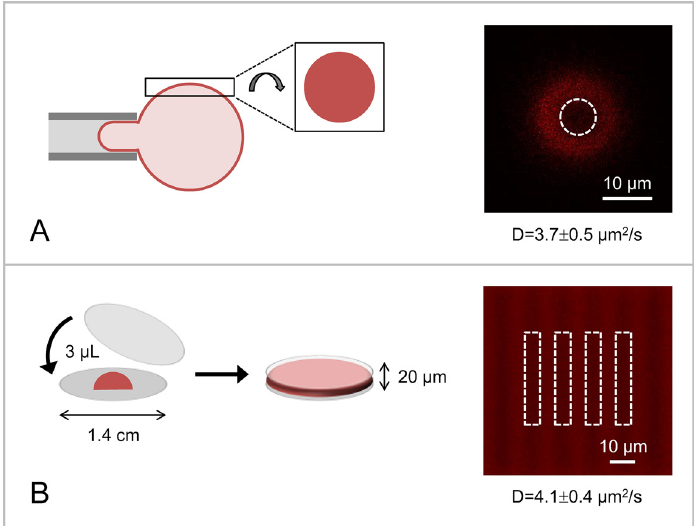
Fig 4. Experimental set-up used to perform FRAP experiments on (A) giant liposomes or (B) sponge phases. (A) To prevent liposome movement during FRAP measurements, giant liposomes are confined in a closed chamber of ~500 μ m height (not shown here) or ideally (as shown here) held through micromanipulation. Fluorescence bleaching and recovery measurements are performed at the top (pole) of the giant liposome, which appears as a fluorescent disk in the confocal microscope. In this system, FRAP measurements are performed using the disk-shaped geometry. To ensure that the bleached spherical cap can be treated as a disk, the diameter of the bleaching disk should not exceed 25% of the giant liposome diameter. The confocal picture on the right shows the result of bleaching a 7 μ m diameter fluorescent disk in the membrane of